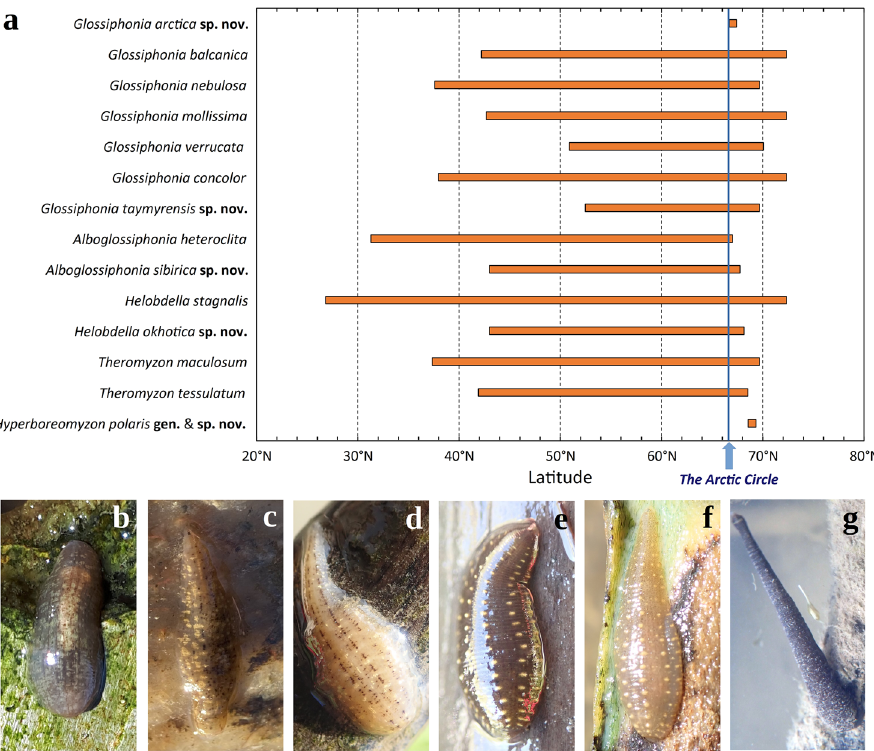
Figure 3. Latitudinal ranges and living individuals of the Arctic Glossiphoniidae species. ( a ) Plot of latitudinal ranges based on the extreme occurrences (northernmost and southernmost record of each species). The occurrence data with precise geographic co-ordinates is presented in Supplementary Dataset S2. ( b ) Glossiphonia arctica sp. nov., a lake near Sob’ railway station, Polar Urals (the type locality). ( c ) G. balcanica (melanic form: f. ‘maculosa’), the same lake. ( d ) G. concolor , a small lake, Dudinka, Taymyr Peninsula. ( e ) G. mollissima (melanic form), Sette-Tala Lake, Chokurdakh, Arctic Yakutia. ( f ) G. mollissima (light-colored form), a small lake, Amguema, Chukotka Peninsula. ( g ) Theromyzon maculosum (melanic form), a small lake, Dudinka, Taymyr Peninsula. Photos: Alexander V. Kondakov ( b , c ) and Olga V. Aksenova ( d – g